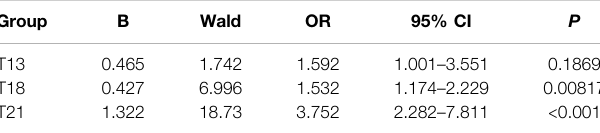
TABLE 5 | Correlation between Z-score and Positive Predictive Value (PPV) by Logistic Regression Analysis. Group